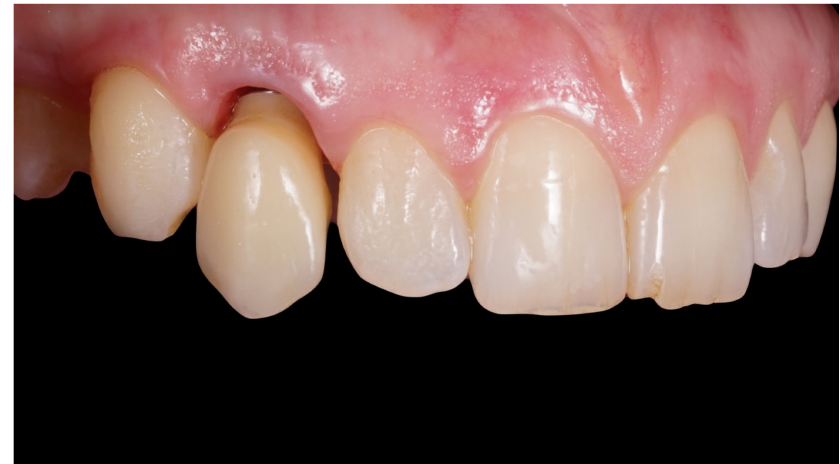
Figure 8. Delivery of final crown.